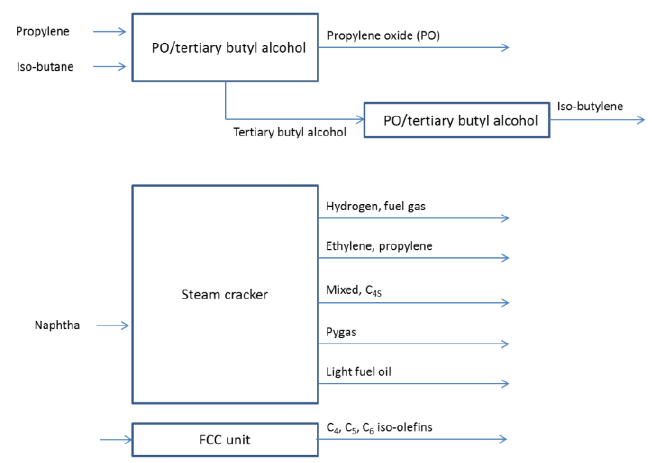
Figure 4. Iso-olefin production in refineries